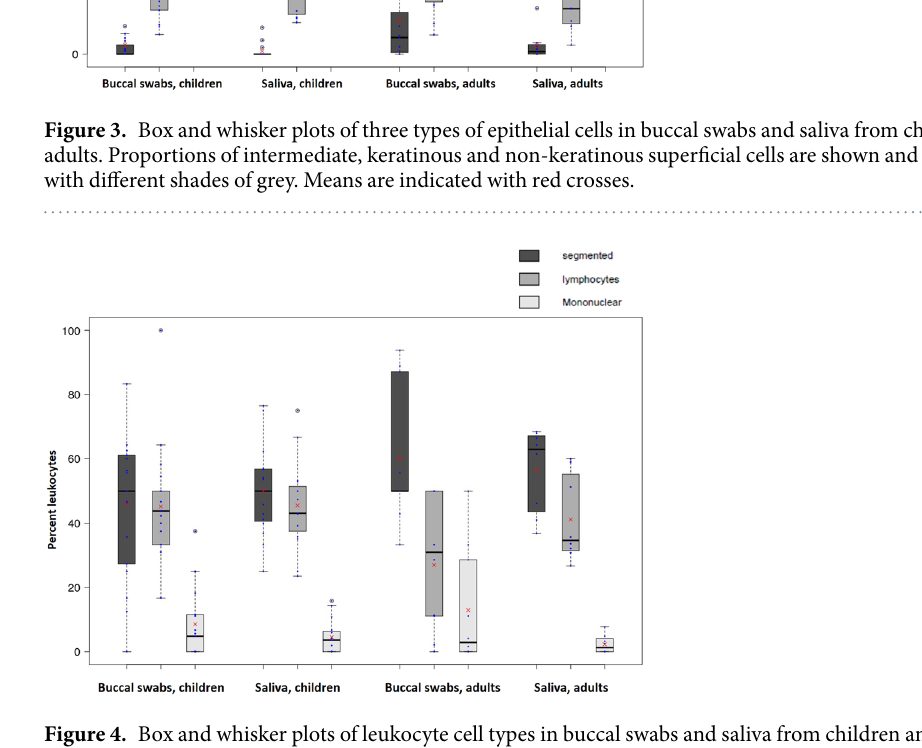
Figure 4. Box and whisker plots of leukocyte cell types in buccal swabs and saliva from children and adults. Proportions of segmented, cells, lymphocytes and other mononuclear cells are shown and means are indicated with red